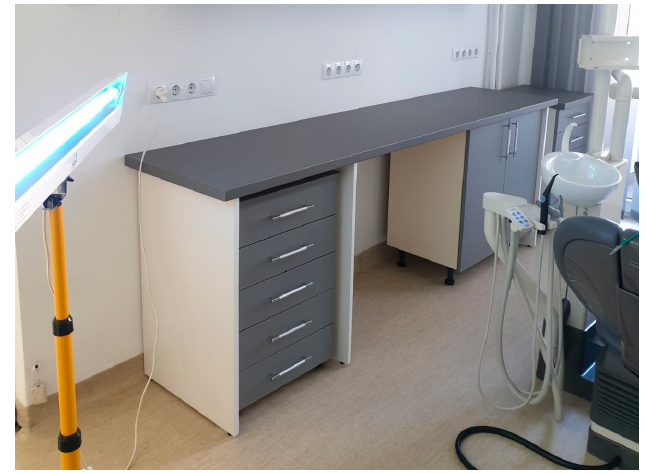
Figure 2. The Ultraviolet C (UVC) lamp.